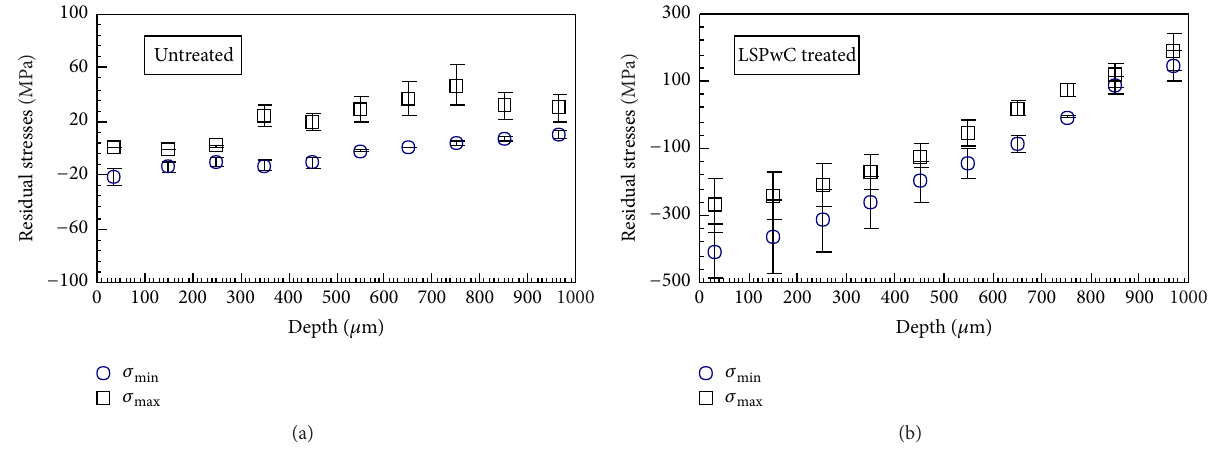
Figure 4: Hole drilling principal residual stresses— 𝜎 RS .